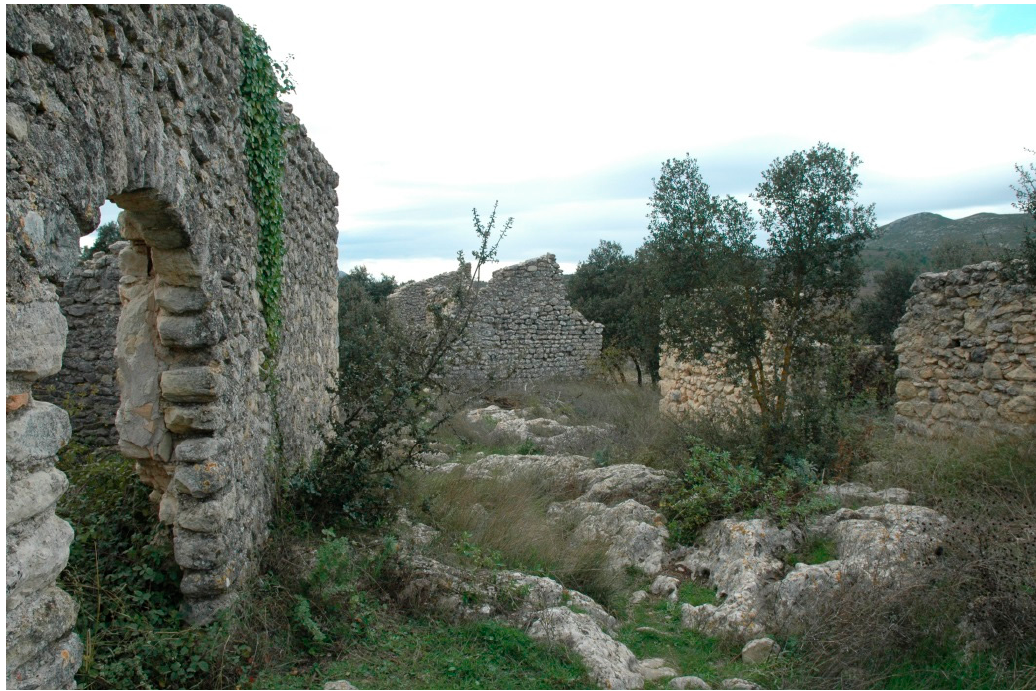
Figure 2. View of the current state of a case. Case: L’Atzuvieta, Vall d’Alcalà.